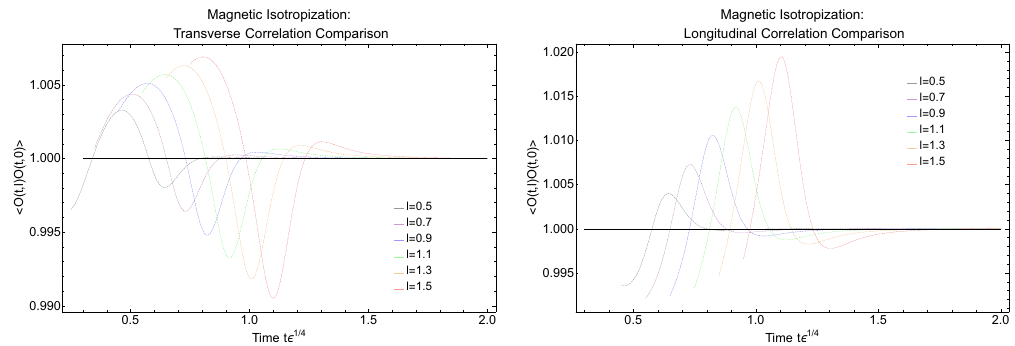
Figure 14 . Small magnetic (cid:12)eld correlators virtually identical to vanishing magnetic (cid:12)eld case. 2- point correlation functions of an (uncharged) scalar operator in a neutral thermalizing (cid:13)uid (dual to the evolution towards a magnetic black brane geometry), (cid:26) = 0, B = 0 : 1. Left: various length sep- arations in the transverse direction. Right: various length separations in the longitudinal